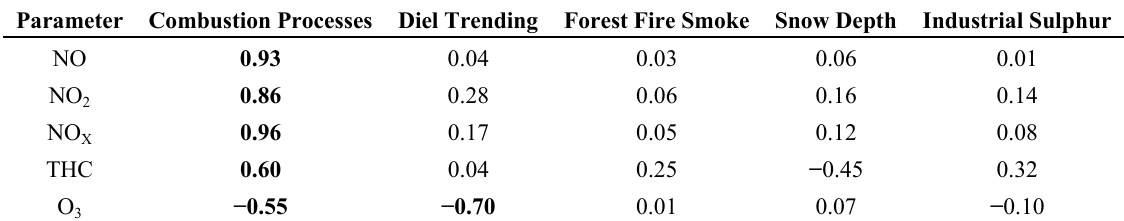
Table 2. Principal component analysis (PCA) rotated factor loadings for the highest 1/3rd of de-trended/seasonally adjusted TGM concentrations ( i.e ., “high” TGM concentrations). Factor loadings with an absolute value greater than or equal to 0.5 are bolded. The shaded row highlights TGM loadings on each